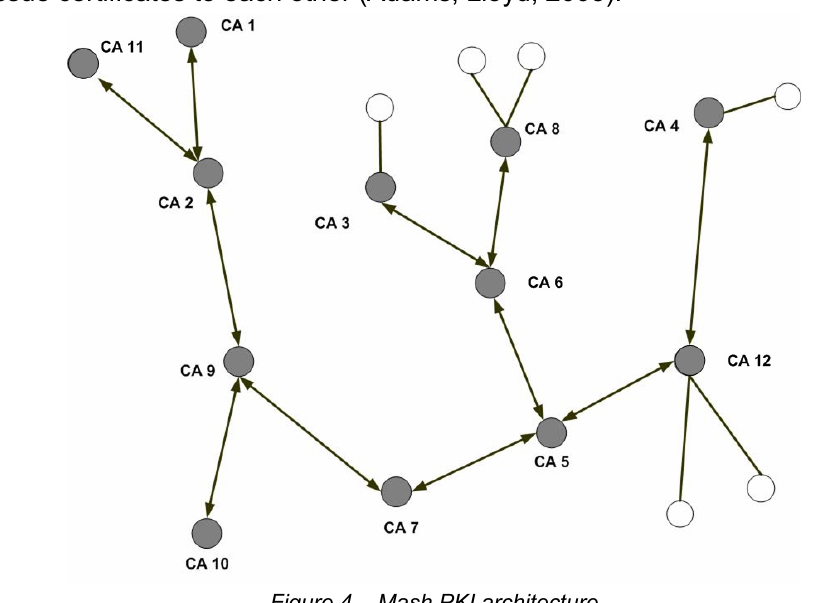
Figure 4 – Mash PKI